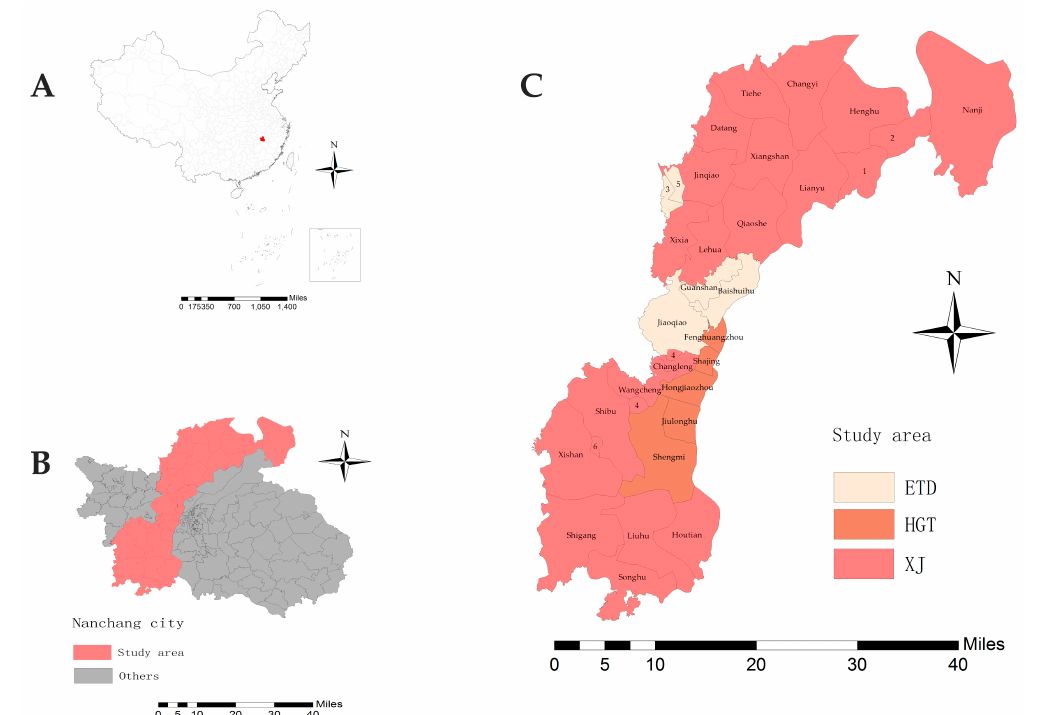
Figure 1. The location of the study area. ( A ) Location of Nanchang city in China. ( B ) Location of the new urban area of Nanchang city. ( C ) Administrative division of the study area (1. Chengxin Industrial Co. Ltd.; 2. Zhugang Industrial Co. Ltd.; 3. Jiangxi Sanghai Group Co. Ltd.; 4. Foreign Invested Industrial Zone of Jiangxi Changleng; 5. Xinqizhou; 6. Xinfeng Farm). The maps were created in ArcGIS software (version 10.2, ESRI Inc., Redlands, CA,